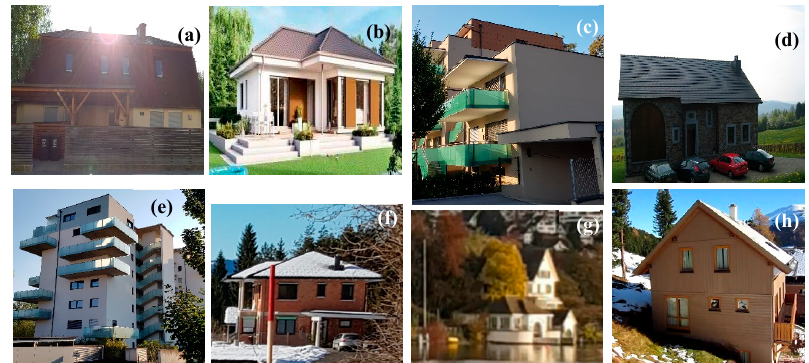
Figure 17. House types which are considered in this work—here some illustrative examples: ( a ) is Farmer house; ( b ) is bungalow; ( c ) is a duplex house; ( d ) is a detached house; ( e ) is an apartment house; ( f ) is a row house; ( g ) is a villa; ( h ) is a country house. (Source of input image: our own images). The developed deep-learning model (made of two modules: see Figures 12 and 15) was trained with 600 images and verified with 200 images and tested with 400 other images. Figure 14 shows the classification confusion matrix with 200 test images obtained by the best classification model (Figures 12 and 15).